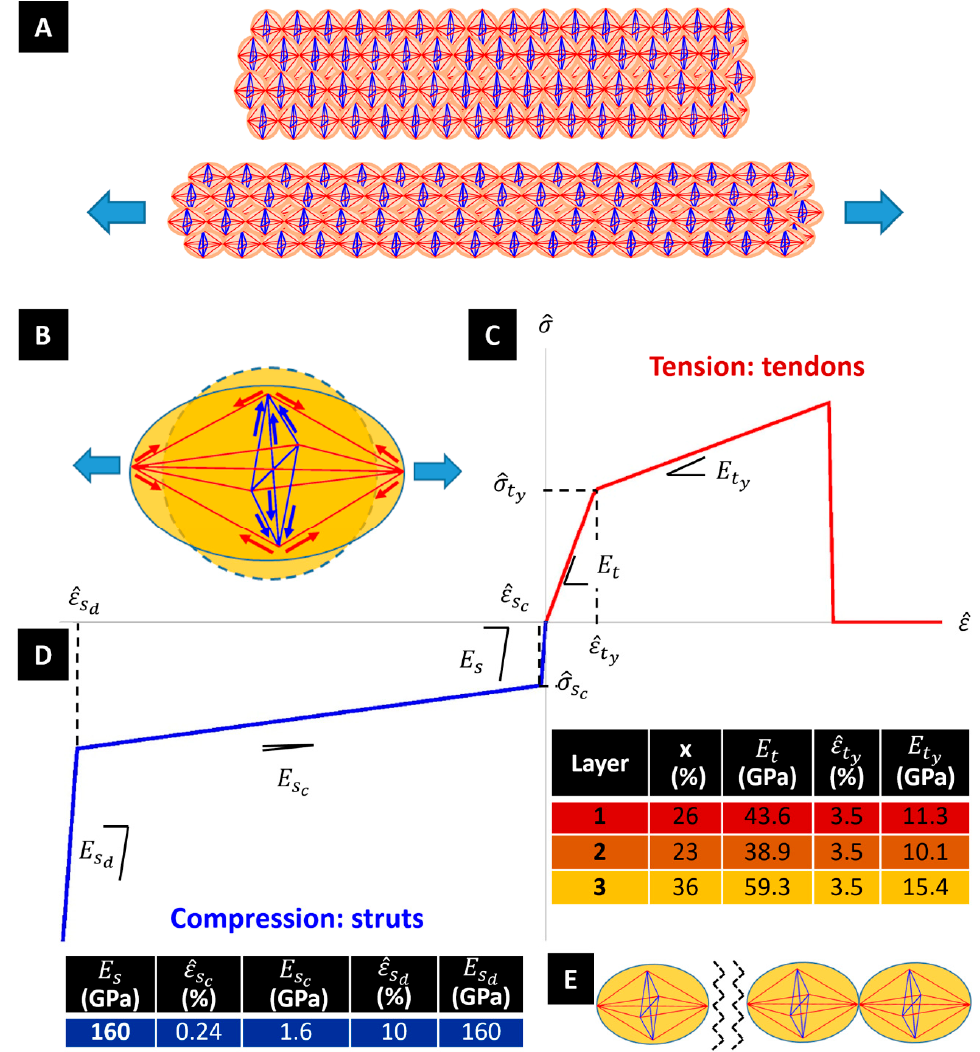
Figure 2. ( A ) Bundle of tensegrity fibrils (red members are tendons, while blue members are struts) and deformation mechanism under tensile loading. ( B ) The tendons are loaded in tension, while the struts are loaded in compression. Stress-strain responses of struts ( C ) and tendons (D ) alongside their respective mechanical parameters. ( E ) Fracture of a fibril at the interface between two adjacent units. The stress-strain response of the struts is characterised by an elastic phase with Young modulus 𝐸 (cid:3046) = 𝐸 (cid:3081) , since these members are supposed to be fully crystalline. The initial elastic response extends up to a buckling event occurring when the local engineering strain reaches the critical value 𝜀̂ (cid:3046)